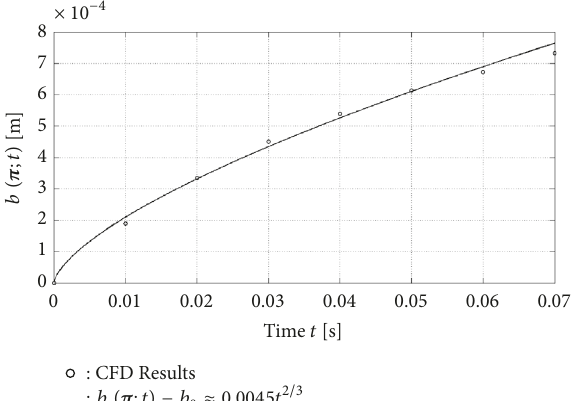
Figure 6: Time evolution of the neck heights 𝑏( 𝜋 ; 𝑡) in the inertial-viscous regime. The circular markers ∘ indicate the numerical experiment results and the solid line represents the fitted curve.